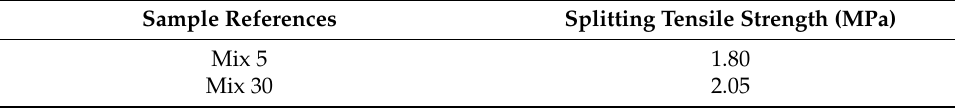
Table 4. Splitting tensile strength at 28 days of curing age.